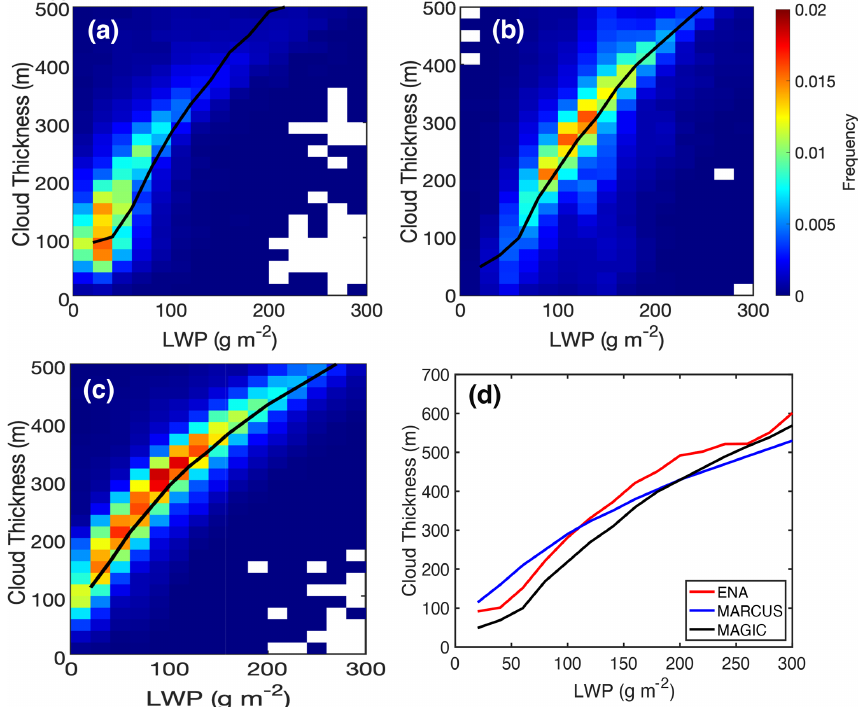
Figure 6. Joint histograms of cloud thickness and LWP in three campaigns: (a) ENA, (b) MARCUS and (c) MAGIC. The black line indicates the mean cloud thickness in each LWP category. For comparison, the relationships between mean cloud thickness and LWP in the three campaigns (black lines in a , b and c ) are shown in (d) .